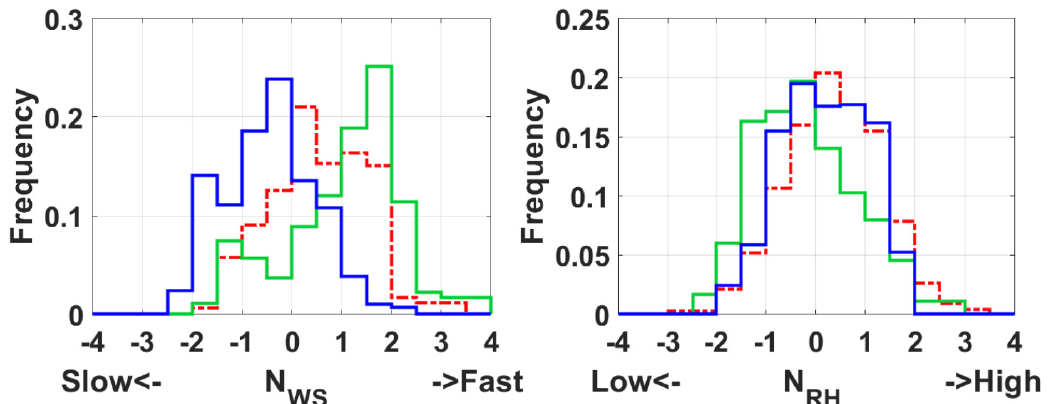
Figure 2. Histogram of N LTS , N BLH , N WS , and N RH for long-range transported haze (LH), yellow sand (YS), and urban haze (UH) cases at Seoul for 2011 to 2016. N x = x where x can be LTS (lower tropospheric stability), BLH (boundary layer height), and WS (wind speed) and RH (relative humidity) of 850 hPa. LTS is the difference between θ 850 and θ 1000 .